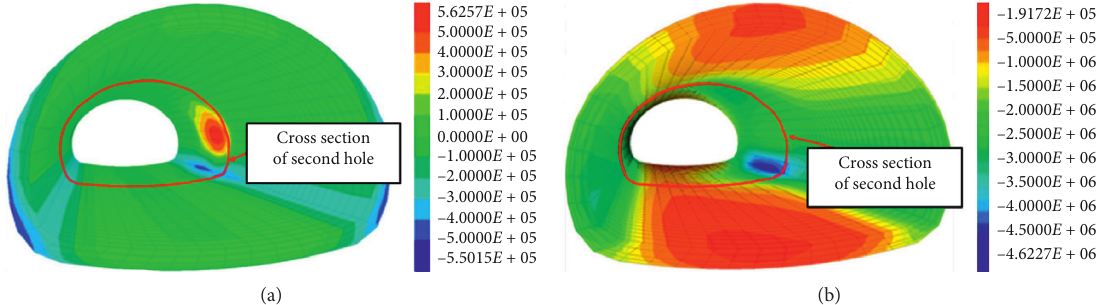
Figure 8: Stress change of the lining of the leading tunnel during peak blasting. (a) Maximum principal stress. (b) Minimum principal